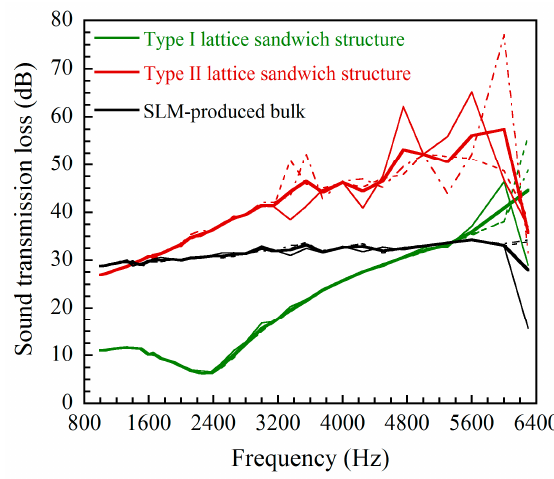
Figure 8. Sound insulation property curves of the three different structural acoustic specimens. (The thin line curves and dotted line curves in this figure are the octave spectrums of each group of sound insulation property test. The three heavy line curves in this figure are the average value curves of the octave spectrums of the three